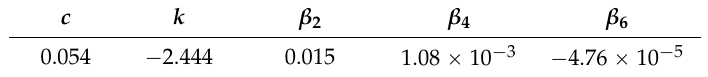
Table 3. Parameters of the aspheric surface of the optics integrated in the front half shell of the housing.